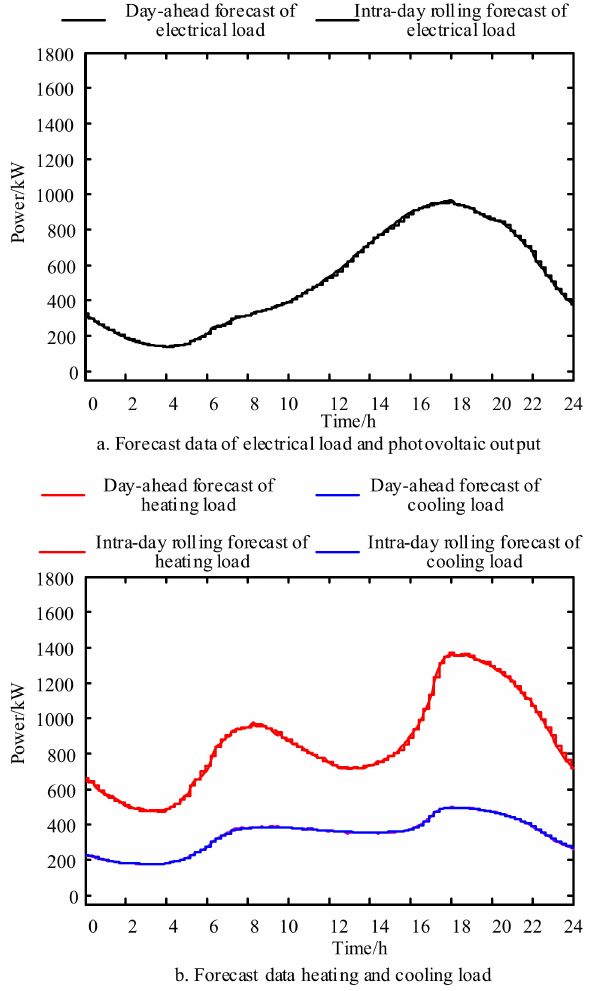
Figure A3. The day-ahead and intra-day forecast curves of PV and load output of the energy station